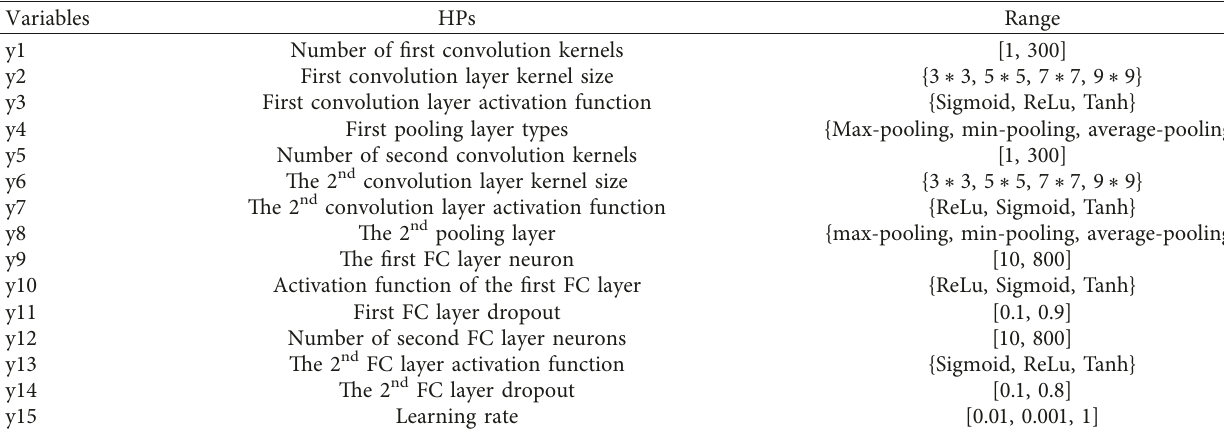
Table 2: PSO for CNN